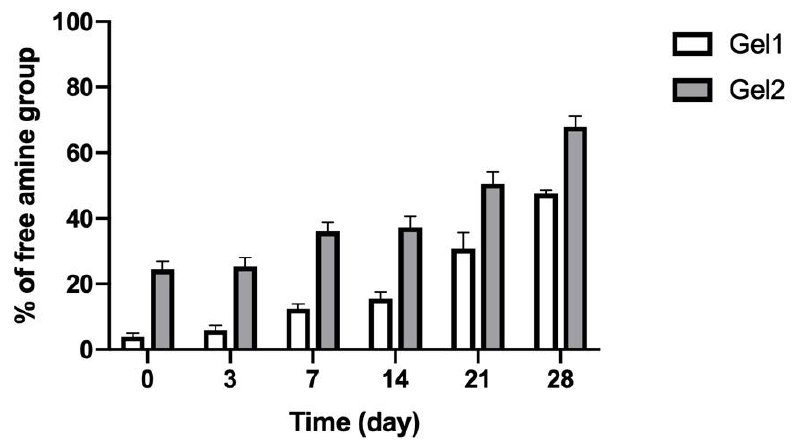
Figure 7. Percentage (%) of free amine groups in CO–HA Gels during in vitro degradation testing in saline at 37 °C over four weeks ( n = 3).